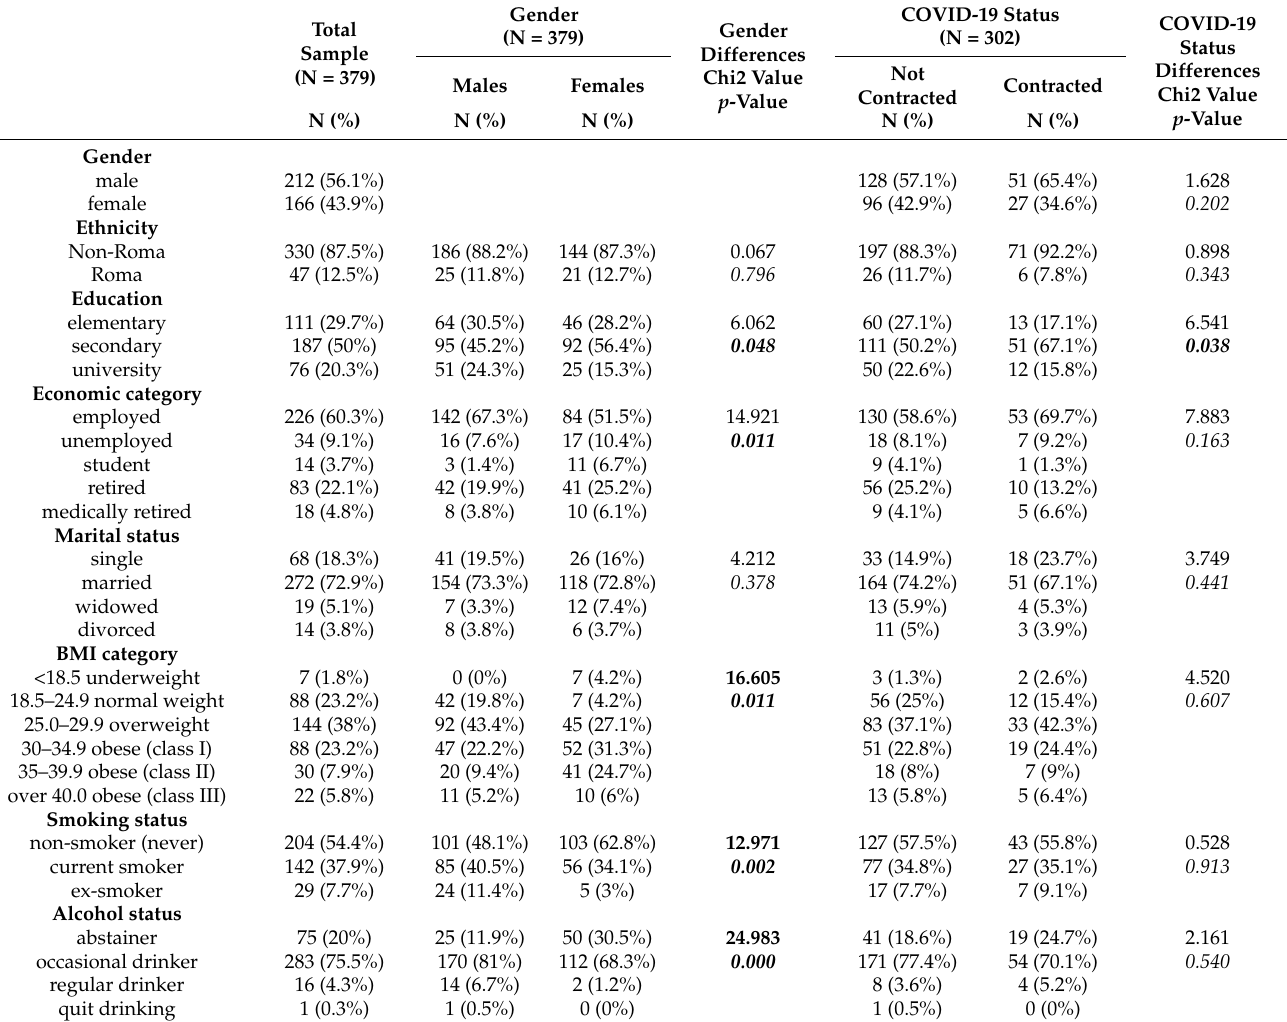
Table 1. Sociodemographic characteristics and psoriatic categories (numbers and relative prevalence in %) presented for the total sample and stratified according to gender and COVID-19 contraction status, differences tested with Pearson’s chi-squared